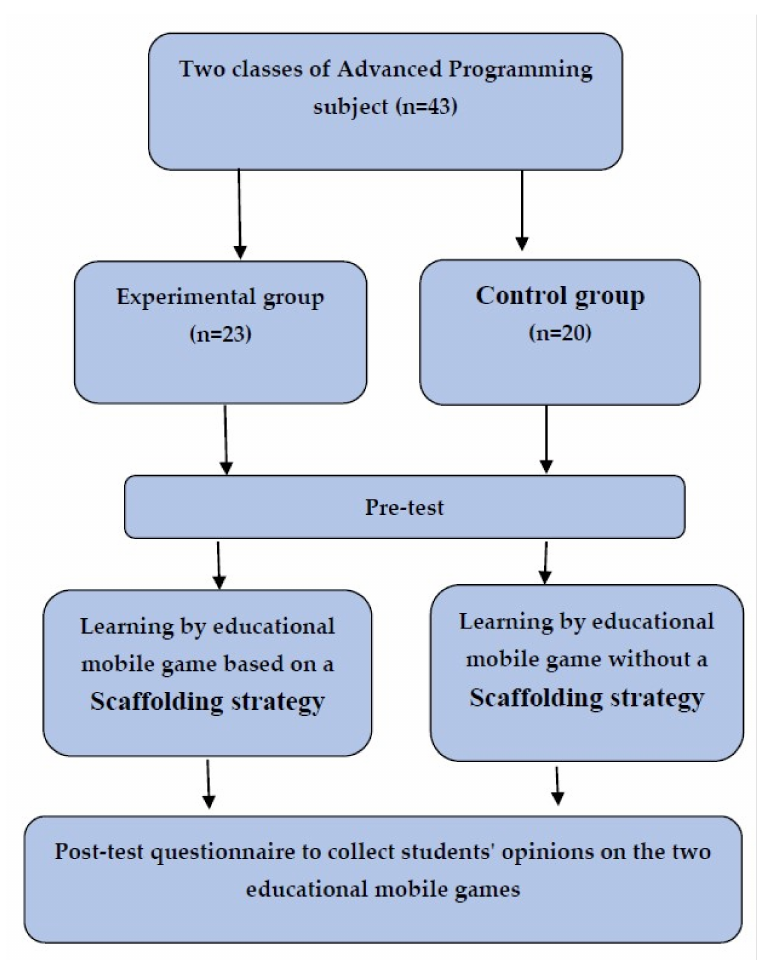
Figure 6. The experimental design